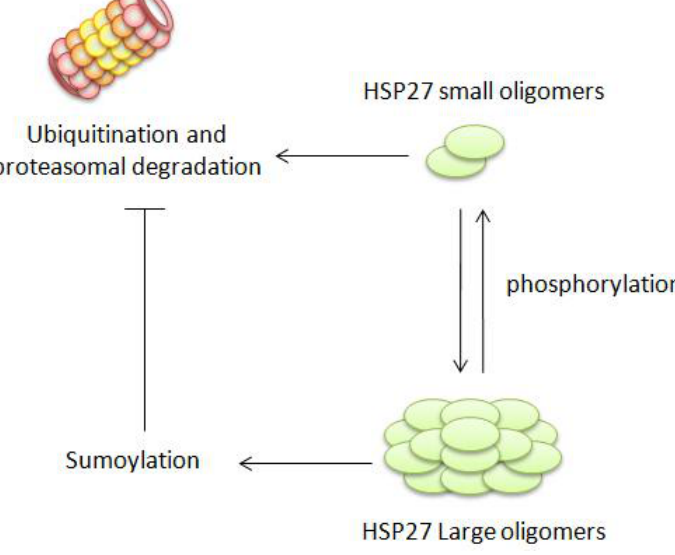
FIGURE 3 . Hypothetic model of how HSP27 may control protein degradation. The oligomerization of HSP27 depends on its phosphorylation status. When phosphorylated, HSP27 forms small oligomers that mediate the ubiquitination and proteasomal degradation of proteins. HSP27 large oligomers are involved in the sumoylation of proteins that might “compete” with and thereby inhibit